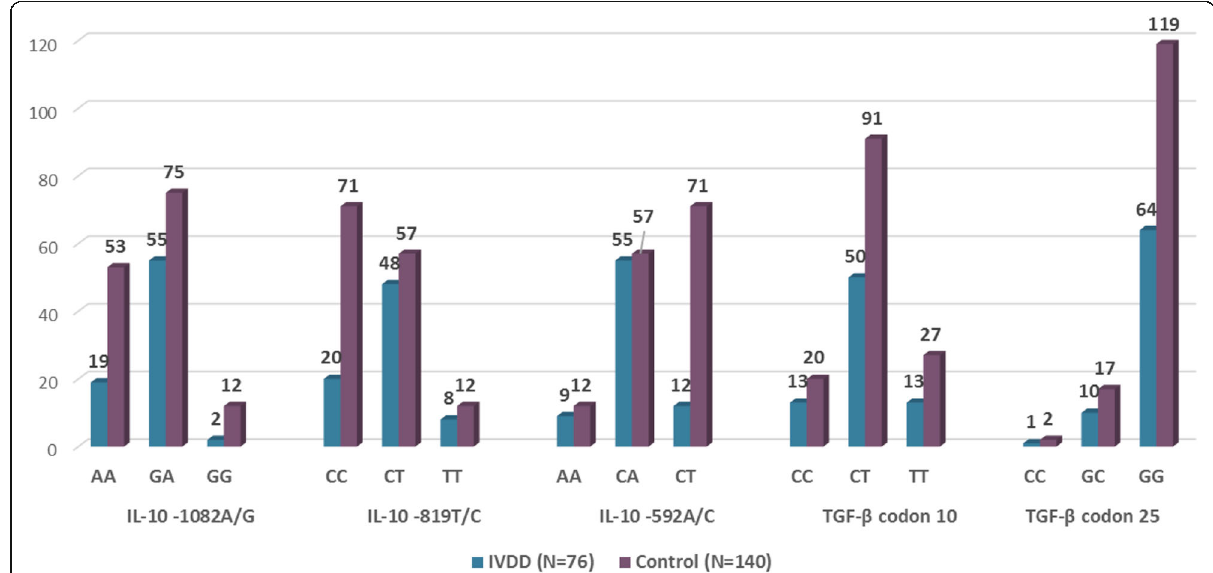
Fig. 2 Genotype Frequencies of IL-10 and TGF- β SNPs in IVDD and